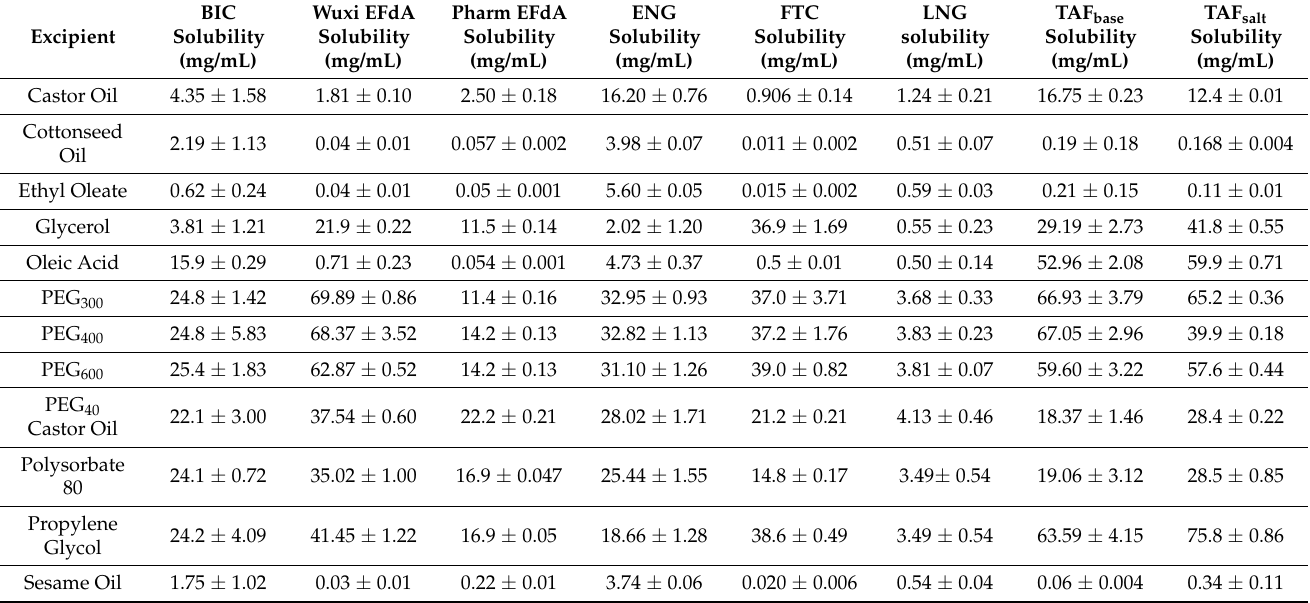
Table 2. The solubility of the API within various pharmaceutical-grade excipients.